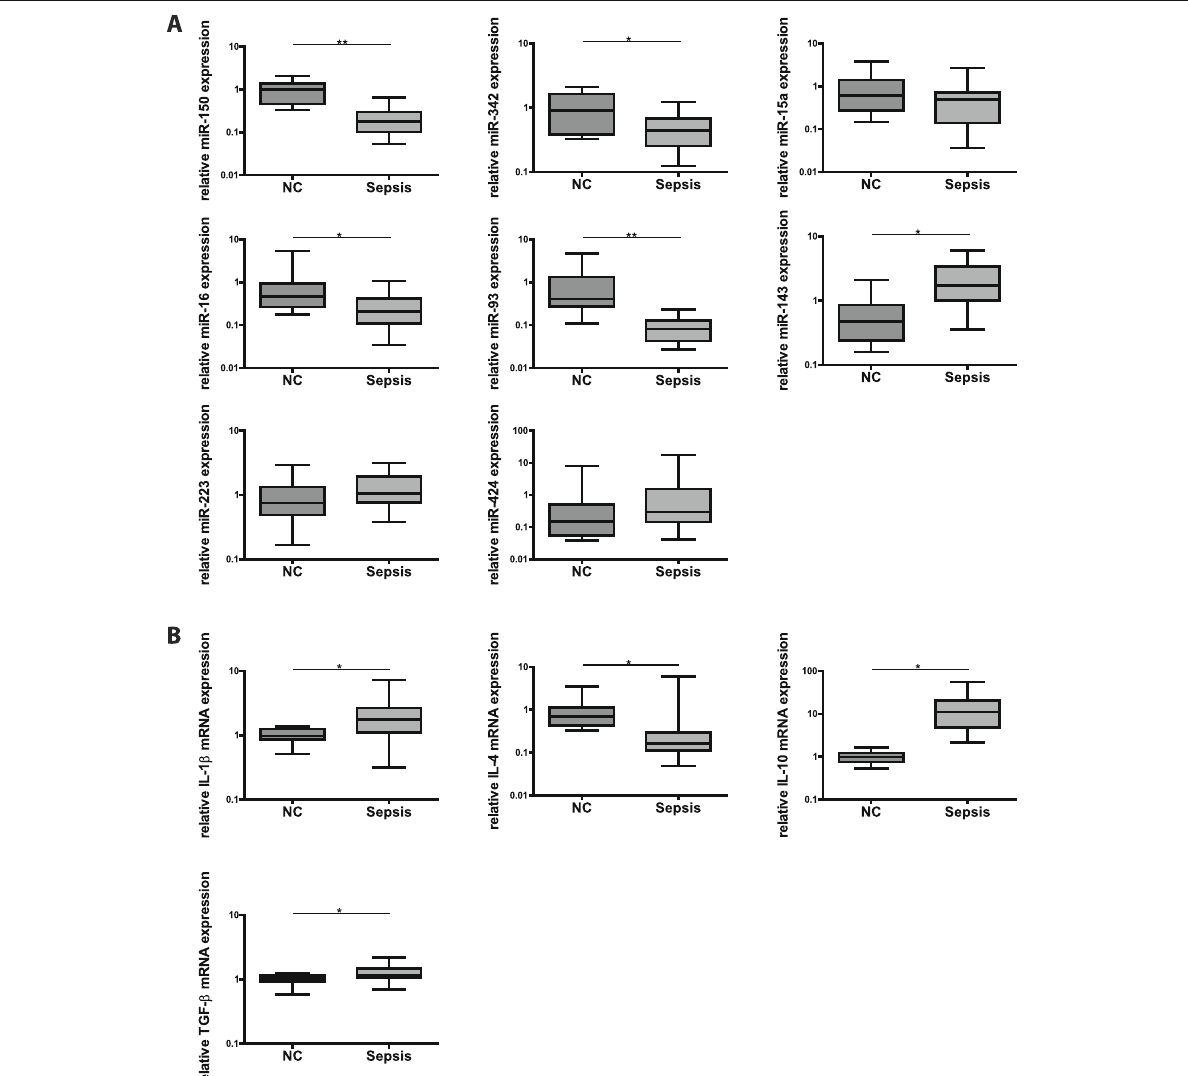
Fig. 4 Simultaneous hyper- and hypoinflammation in whole blood of septic patients. a MiRNA expression in human whole blood obtained from septic patients as compared to healthy controls. Expression levels of miR-150, miR-342, miR-15a, miR-16, miR-93, miR-143, miR-223 and miR-424 were assessed by TaqMan miRNA assays relative to U47. Data are shown as median, 25th and 75th percentile and outliers, n = 10/20 (NC/Sepsis) performed in duplicates. Values represent expression relative to controls, * p < 0.05, ** p < 0.001. Quantification cycle (Cq) values for the single miRNAs were in the range of 24 (NC) and 26 (Sepsis) for miR-150, 26 (NC) and 27 (Sepsis) for miR-342, 30 (NC) and 31 (Sepsis) for miR-15a, 21 (NC) and 23 (Sepsis) for miR-16, 26 (NC) and 29 (Sepsis) for miR-93, 34 (NC) and 33 (Sepsis) for miR-143, 21 (NC and Sepsis) for miR-223, 40 (NC) and 39 (Sepsis) for miR-424, respectively. b Cytokine expression in human whole blood obtained from septic patients as compared to healthy controls. mRNA levels of IL-4, IL-1 β , IL-10 and TGF- β were measured by qPCR relative to reference genes SDHA and TBP. Data are shown as median, 25th and 75th percentile and outliers, n = 10/20 (NC/Sepsis) performed in duplicates. Values represent expression relative to controls, * p < 0.05, ** p < 0.001. Quantification cycle (Cq) values for the single cytokines and receptors were in the range of 32 (NC) and 35 (Sepsis) for IL-4, 27 (NC and Sepsis) for IL-1 β , 35 (NC) and 32 (Sepsis) for IL-10, 24 (NC) and 25 (Sepsis) for TGF- β ,